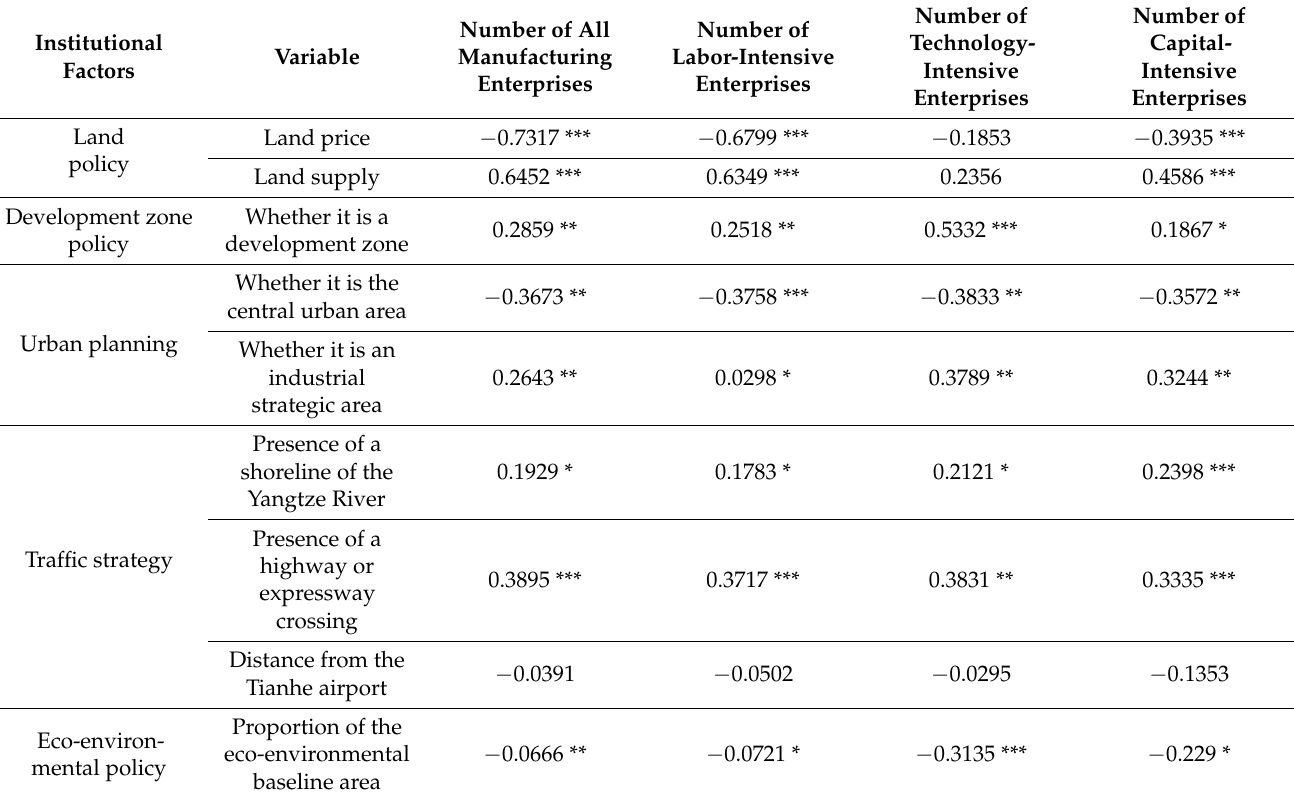
Table 3. Regression results of manufacturing industry location in the Wuhan metropolitan